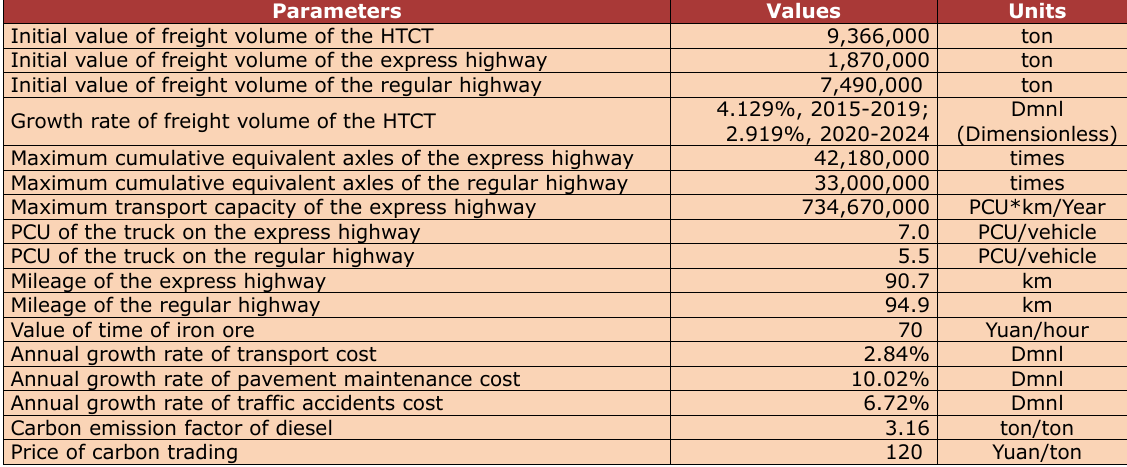
Table 2. The key parameters used in the